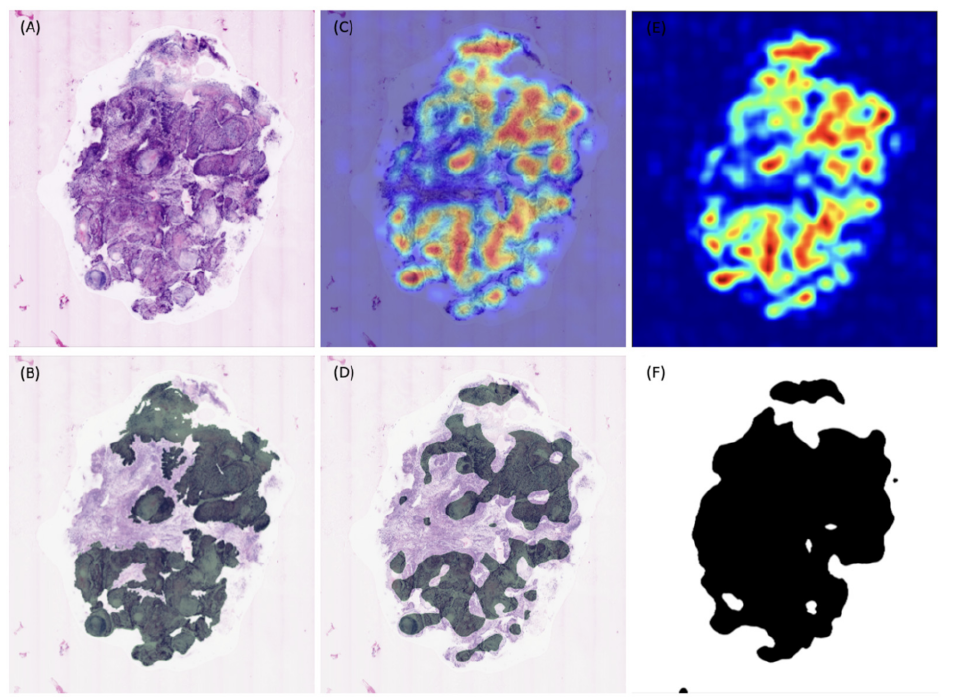
Figure 1. Image processing beginning from the digital staining mode of the ex vivo confocal image ( A ) as the ground truth; to the segmentation step performed by an expert, highlighted in green ( B ), heatmap overlaid on the tissue, the colormap used is jet, which ranges from blue to red, where red signifies tumor tissue and blue signifies tumor free tissue ( C ), as well as tissue marked as ROI by the algorithm ( D ), heatmap ( E ) and the tissue separation mask ( F